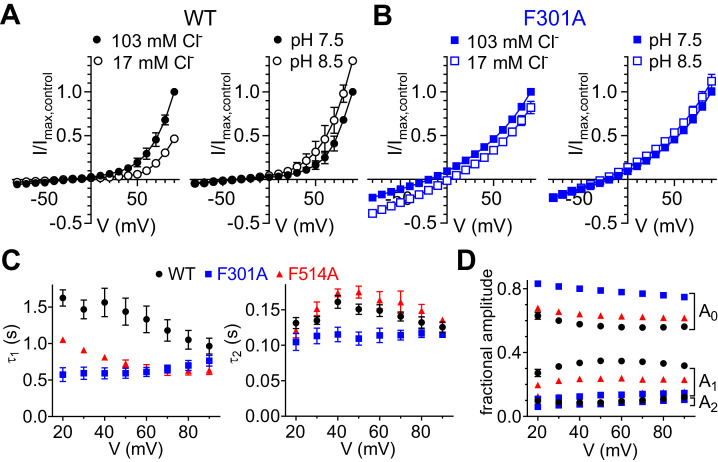
Impact of Phecen (F514) and Pheex (F301) mutagenesis on CLC-7 exchanger function.(A) Normalized I-V relationships of CLC-7 WT showing dependence on extracellular [Cl-] (left; N = 2) and [H+] (right; N = 2). (B) Normalized I-V relationships of CLC-7 F301A showing dependence on extracellular [Cl-] (left; N = 5) and [H+] (right; N = 5). (C, D) The time courses of current activation of CLC-7 WT (N = 8), F301A (N = 8) and F514A (N = 8) at voltages between +20 and +90 mV were fit to a biexponential function (see Materials and methods, Equation 2). (C) The slow (τ1, left) and fast (τ2, right) time constants of CLC-7 WT (black circles), F301A (blue squares) and F514A (red triangles) are plotted as a function of voltage. F301A strongly diminishes voltage dependence of both activation time constants (τ1, τ2; at every tested voltage p<0.05). F514A accelerates the slow time component τ1 (at every tested voltage p<0.005). (D) The fractional amplitudes A0, A1 and A2 for CLC-7 WT (black circles), F301A (blue squares) and F514A (red triangles) are plotted as a function of voltage. F301A increases the time-independent fractional amplitude A0 and decreases the contribution of time-dependent fractional amplitude A1 (at every voltage tested p<0.005). F514A increases A0 and decreases A1 (at every voltage tested p<0.005). All values are reported as mean ± S.E.M, error bars are not shown where they are smaller than the symbol size. The raw data for the traces shown is available in Figure 5—figure supplement 1—source data 1.Figure 5—figure supplement 1—source data 1.Individual raw data points.